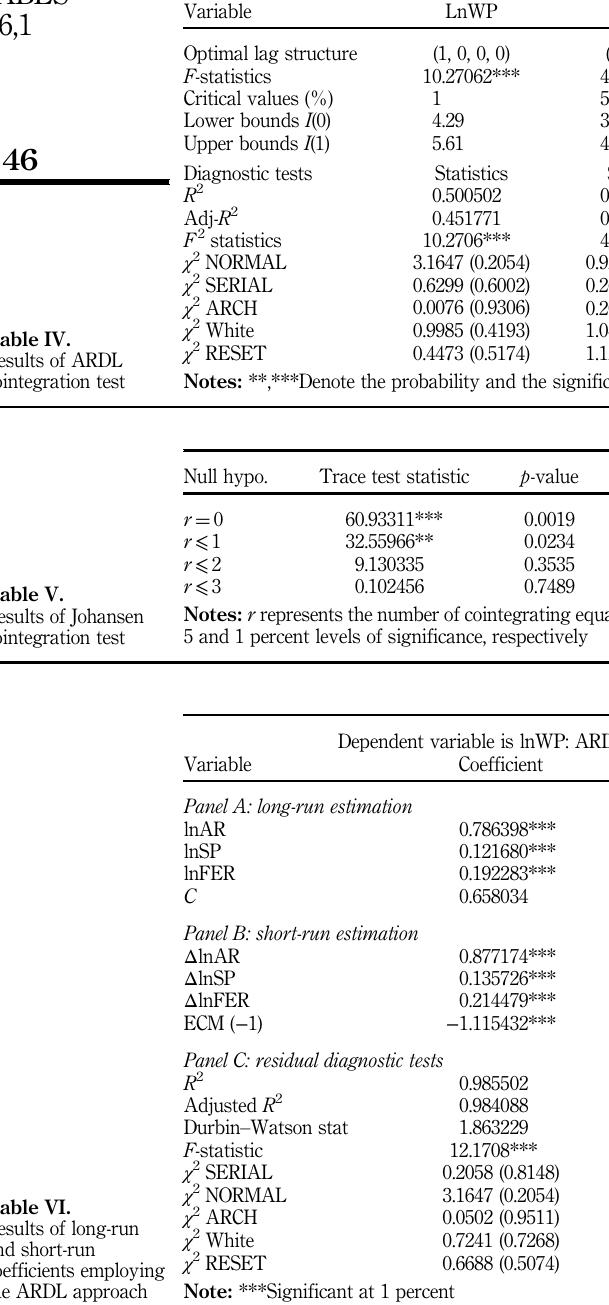
and short-run coefficients employing the ARDL